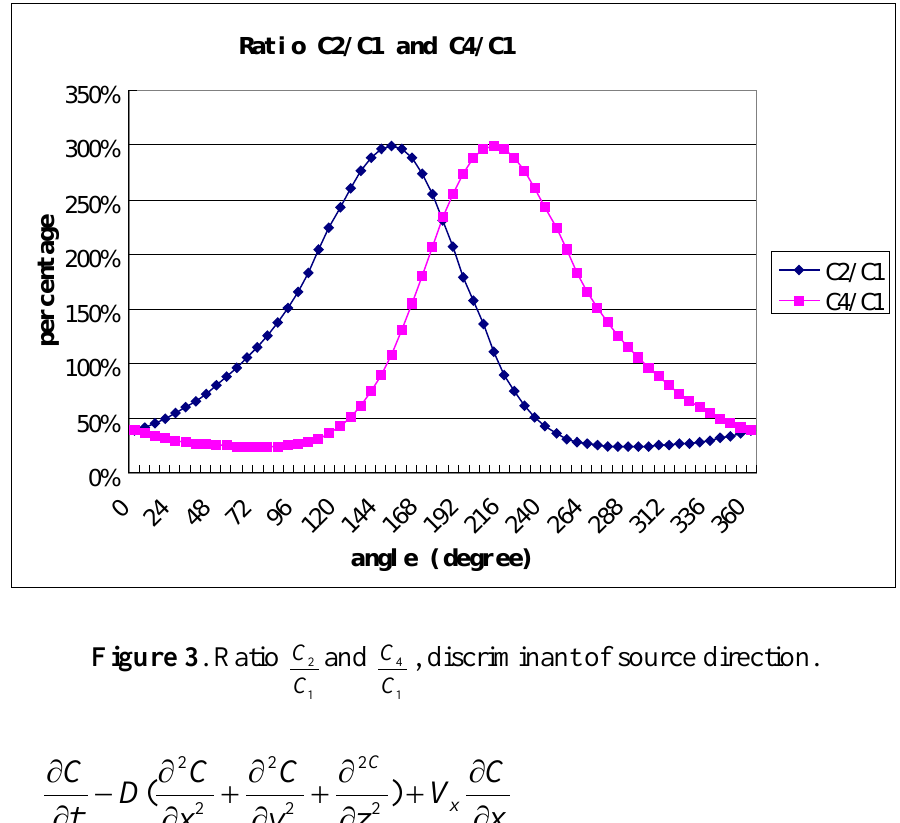
CC and CC , discriminant of source 12 14